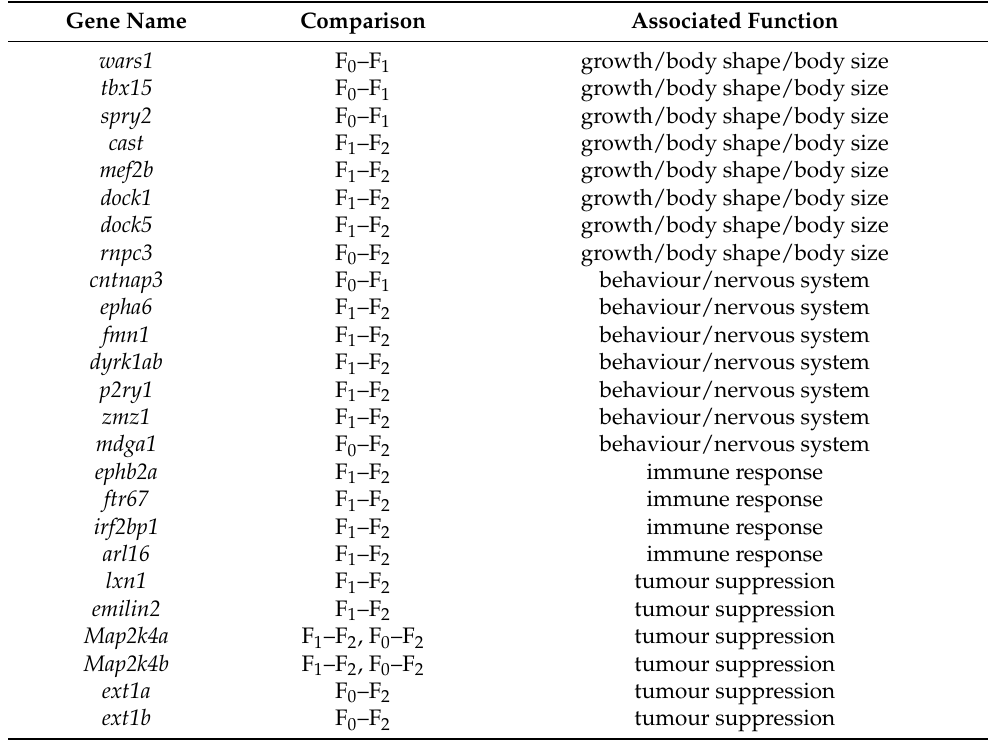
Table 2. Overview of the genes along with the function they are associated with, as well as the populations used in the comparison.